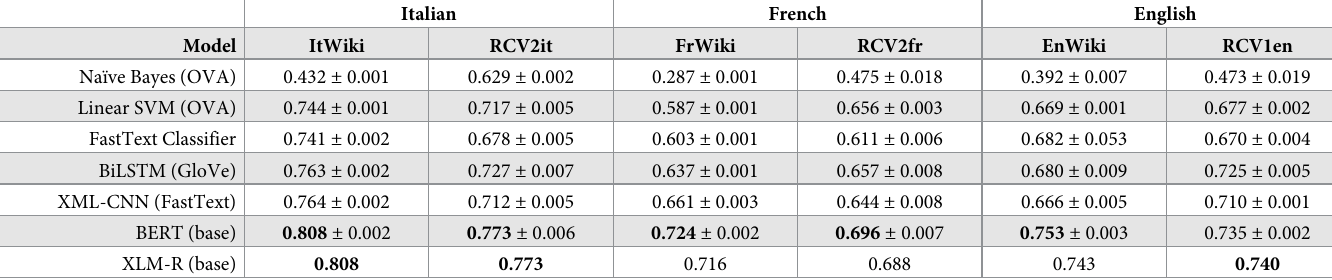
Table 11. Test set subset accuracy score for the tested TC